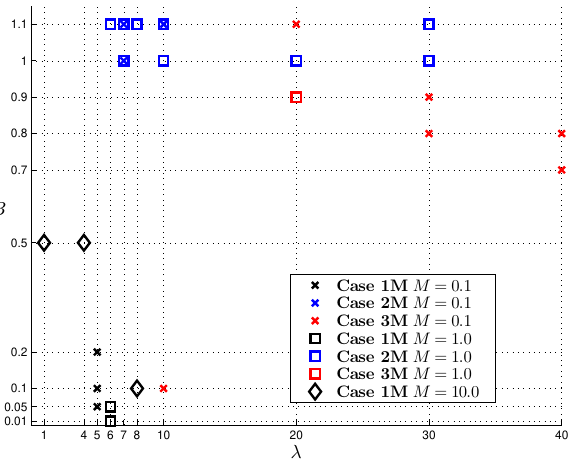
Figure 12. The position of the points in parameter space indicates which case occurs. The picture shows only the couples ( λ , B ) for given M of Table 2.